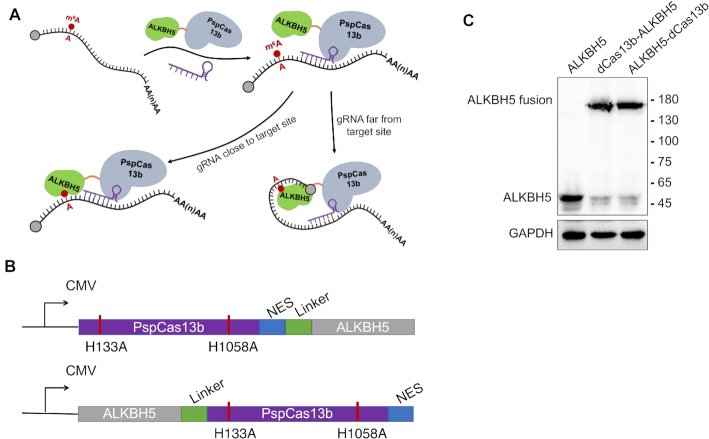
Design of dm6ACRISPR for targeted RNA demethylation. (A) Overview of site-specific RNA targeting using dCas13b-guided fusion proteins with gRNA close to or away from the target site; (B) Schematic representation of the domain organization of dCas13b-ALKBH5 or ALKBH5-dCas13b expression cassette; (C) Expression of dCas13b-ALKBH5 and ALKBH5-dCas13b fusion protein in HeLa cells measured by western blotting using ALKBH5 antibody.